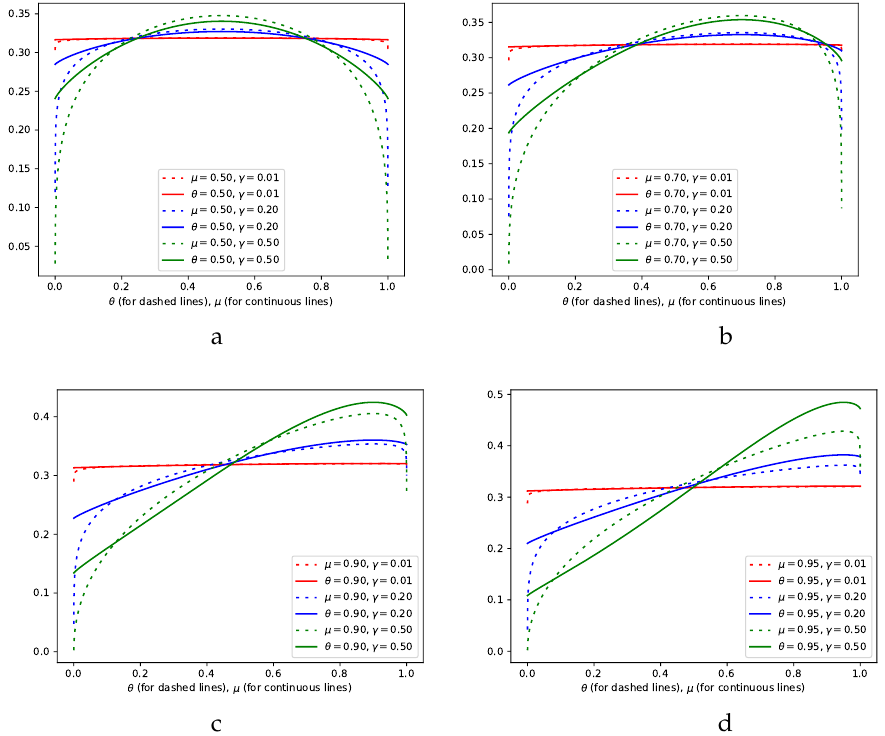
Figure 4. Comparison of p γ · D ( θ | µ ) and p γ · D ( µ | θ ) . In ( a ) p γ · D ( θ | µ = 0.5 ) and p γ · D ( µ | θ = 0.5 ) . In ( b ) p γ · D ( θ | µ = 0.7 ) and p γ · D ( µ | θ = 0.7 ) . In ( c ) p γ · D ( θ | µ = 0.9 ) and p γ · D ( µ | θ = 0.9 ) . In ( d ) p γ · D ( θ | µ = 0.95 ) and p γ · D ( µ | θ = 0.95 )